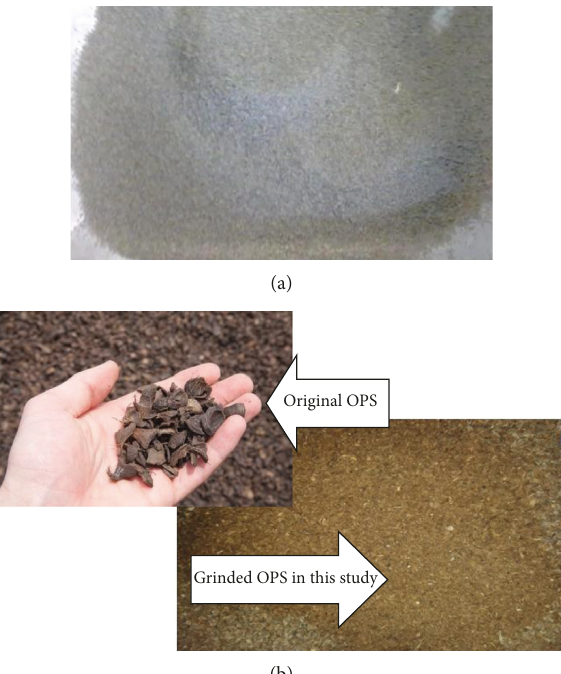
Figure 2: Filter materials. (a) Quarry gravels and (b) oil palm shells